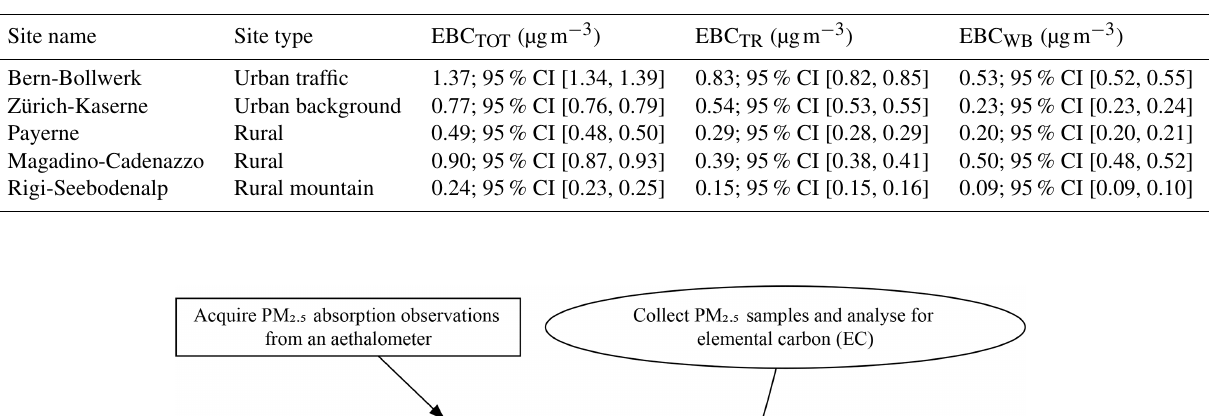
Table A2. Summary statistics for daily equivalent black carbon (EBC) at five monitoring sites in Switzerland between 2008 and 2018. CI: confidence interval.